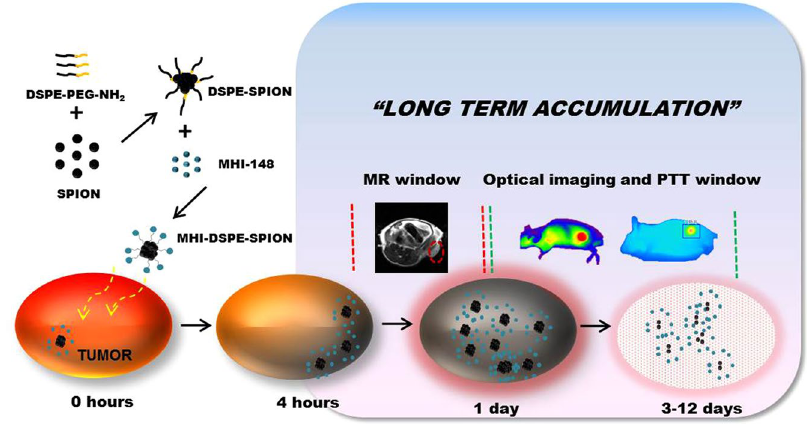
Figure 1. Schematic illustration showing the overall concept of the present study. MHI-DSPE-SPION designed for MRI application by using the magnetism of the nanoparticle core of SPION (black) in addition to optical imaging along with PTT by MHI-148 ligands (green) of the nanoparticle shell